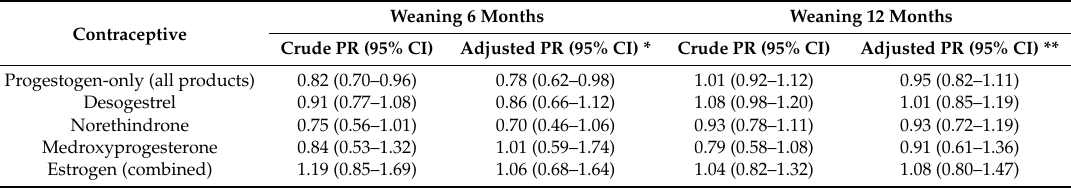
Table 5. Exposure to hormonal contraceptives during the first 3 months postpartum and weaning (excluding mothers who did not breastfed or weaned before 3 months), N = 2769. Pelotas (Brazil) Birth Cohort Study,